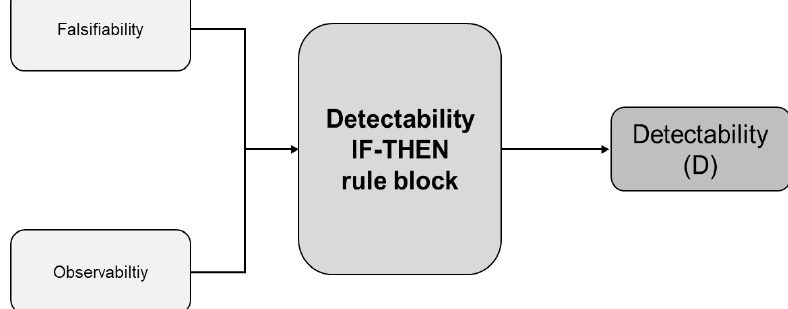
Figure 2. Logical scheme of inference rules for the Failure Mode, Effects, and Criticality Analysis (FMECA) index Detectability (D).